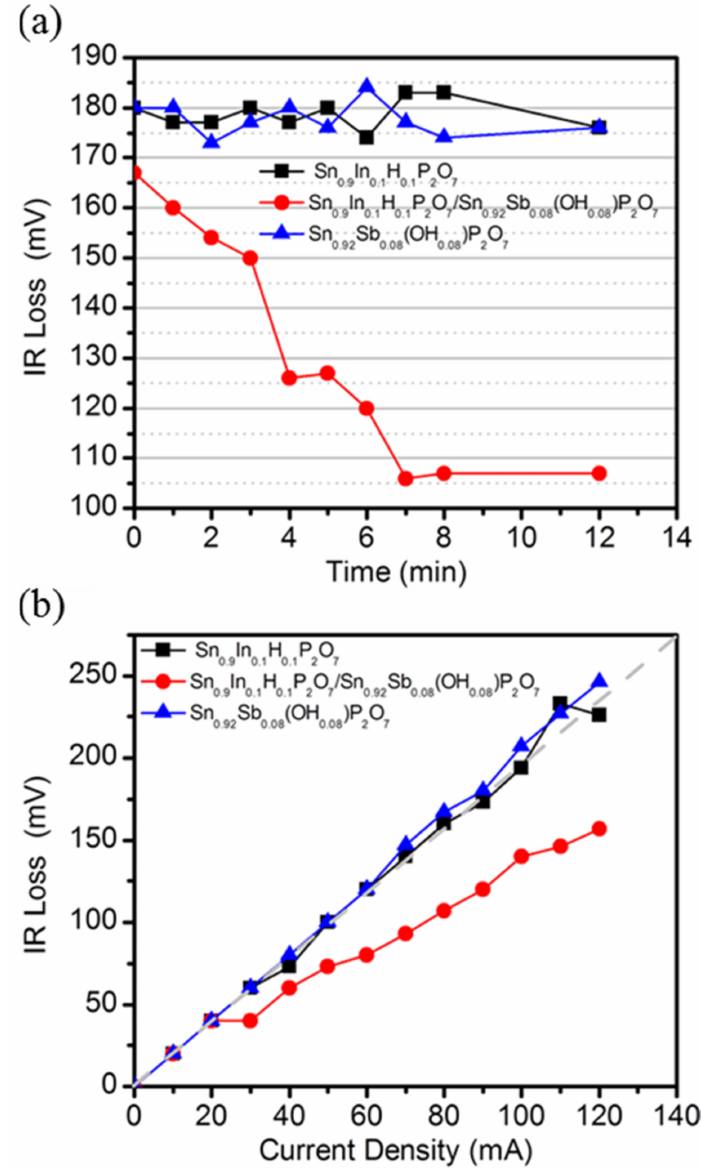
Figure 5. Change in IR losses for Sn 0.9 In 0.1 H 0.1 P 2 O 7 , Sn 0.92 Sb 0.08 (OH) 0.08 P 2 O 7 , and Sn 0.9 In 0.1 H 0.1 P 2 O 7 /Sn 0.92 Sb 0.08 (OH) 0.08 P 2 O 7 membranes with respect to ( a ) time and ( b ) current density. The cells were operated at 100 ◦ C with unhumidified H 2 and air saturated with H 2 O vapor at room temperature ( P H 2 O = 0.035 atm) as reactor gases for anode and cathode, respectively. To clarify the self-humidification effect during the fuel cell performance, the IR losses of the fuel cells with the individual Sn 0.9 In 0.1 H 0.1 P 2 O 7 and Sn 0.92 Sb 0.08 (OH) 0.08 P 2 O 7 membranes with different P H 2 O conditions from 0.035 to 0.690 atm were measured and compared with those of the Sn 0.9 In 0.1 H 0.1 P 2 O 7 /Sn 0.92 Sb 0.08 (OH) 0.08 P 2 O 7 membrane at a P H 2 O of 0.035 atm (Figure 6a,b). A comparison between the fuel cells with the Sn 0.9 In 0.1 H 0.1 P 2 O 7 /Sn 0.92 Sb 0.08 (OH) 0.08 P 2 O 7 and individual Sn 0.9 In 0.1 H 0.1 P 2 O 7 or Sn 0.92 Sb 0.08 (OH) 0.08 P 2 O 7 membranes confirmed that the IR loss of the former membrane at a P H 2 O of 0.035 atm was equivalent to that of the latter two membranes at P H 2 O between 0.465 and 0.690 atm, indicating that the present heterojunction fuel cell can successfully enhance the electrolyte properties without the need for external